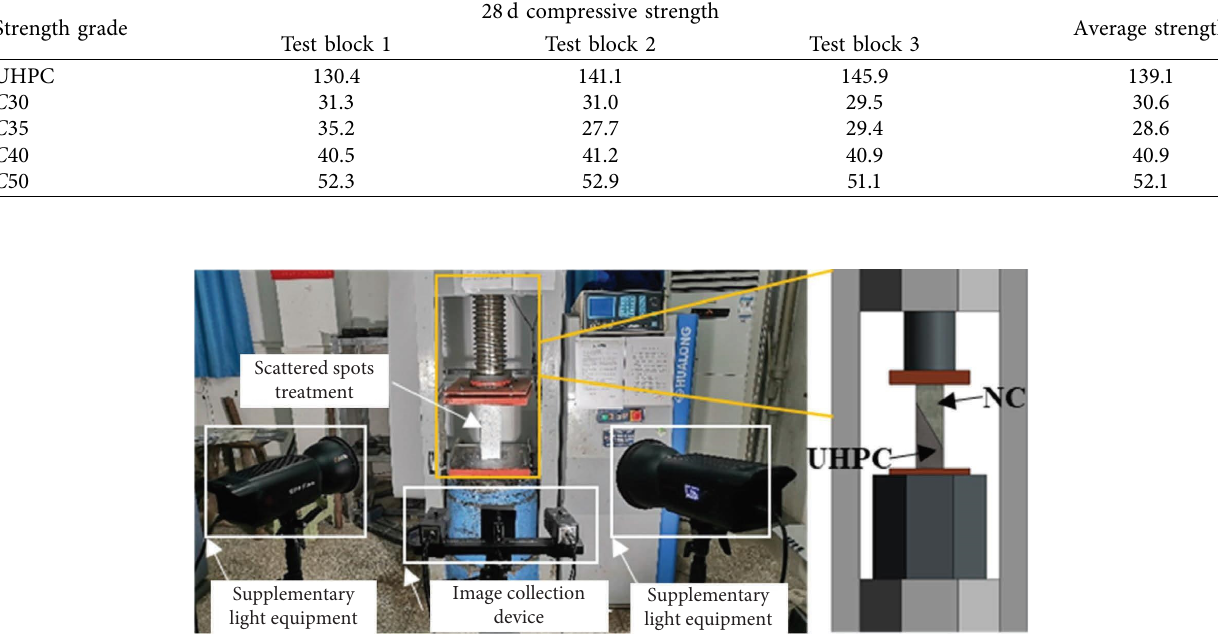
Figure 3: Loading and monitoring devices.